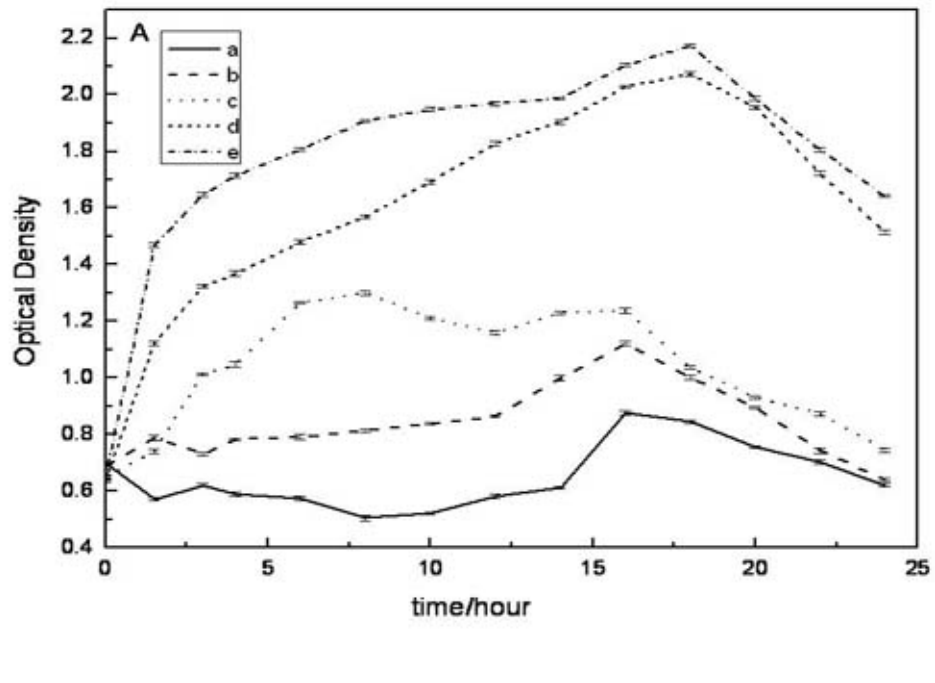
Figure 3. Growth curves of E. coli and S. aureus in the presence of CS/SF as measured at 570 nm. ( A ) E. coli ; ( B ) S. aureus (a) CS/SF (80/20); (b) CS/SF (50/50); (c) CS/SF(20/80); (d) pure SF; (e) control